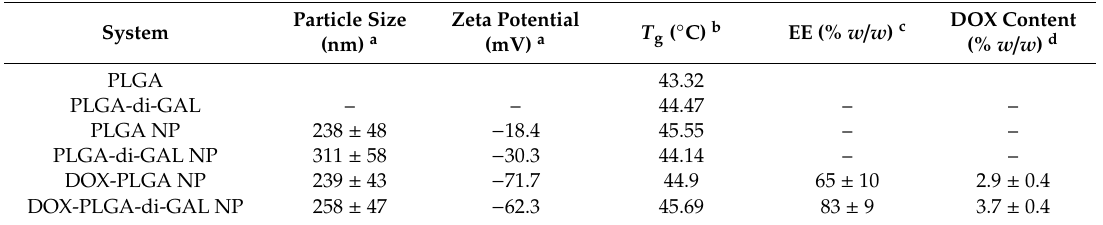
Table 2. Particle size, zeta potential, polymer glass transition temperature ( T g ), encapsulation e ffi